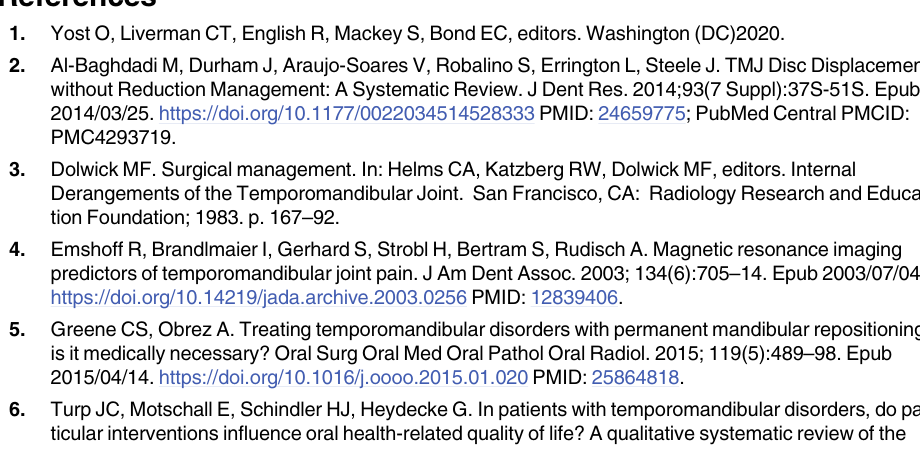
S1 Fig. Summary of histopathological findings showing changes from the control side in each